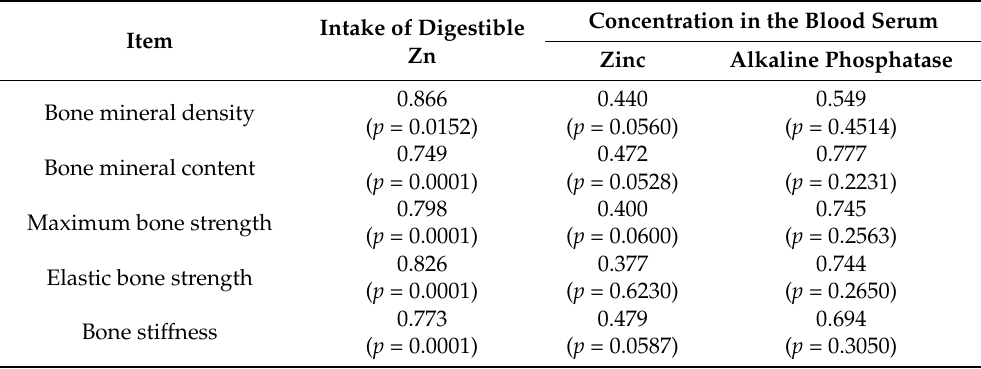
Table 5. Pearson’s correlation coefficient between bone parameters vs. the daily intake of Zinc and the content of zinc and alkaline phosphatase in the blood